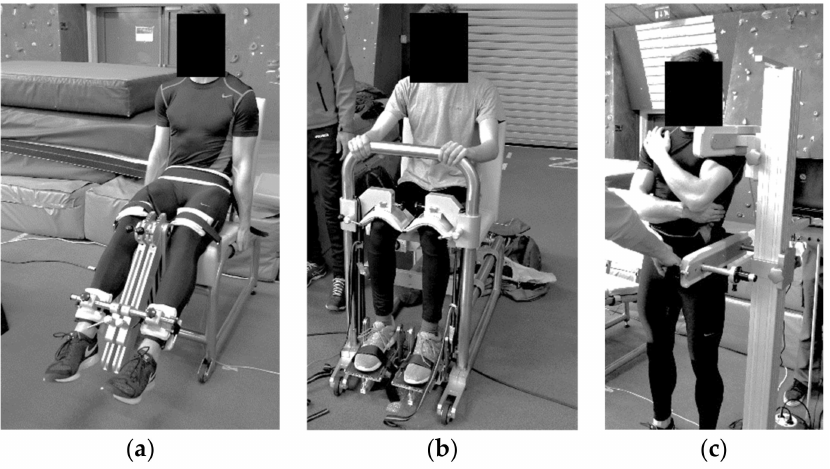
Figure 1. Isometric strength measurements of the ( a ) knee, ( b ) ankle and ( c ) trunk muscles. Hip muscle assessment was performed with participants positioned supine (abduc- tion, adduction and flexion) or prone (extension, internal and external rotation) on the dynamometer’s platform (Figure